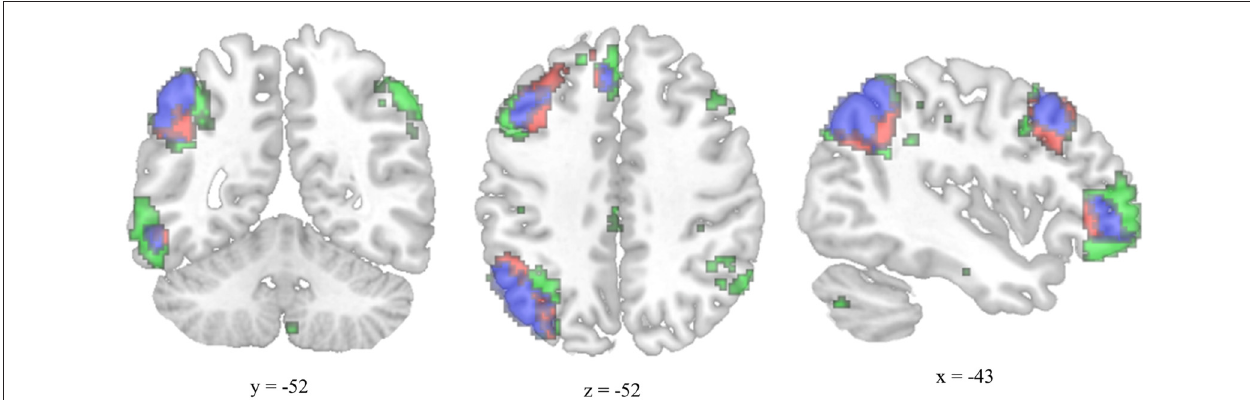
FIGURE 6 | Overlap between the functional connectivity map of the degree-centrality-based MTG cluster and the left executive control network. The left executive control network was mapped using a template from Shirer et al. (2012). The functional connectivity map for the left-hemisphere MTG cluster was generated using pre-test resting-state images from all participants and thresholded for viewing purposes using a cluster forming threshold set at p < 0.001 and a cluster size threshold set at p < 0.05 (FDR corrected). Executive control network template is green, MTG connectivity map is red, and overlap is blue.